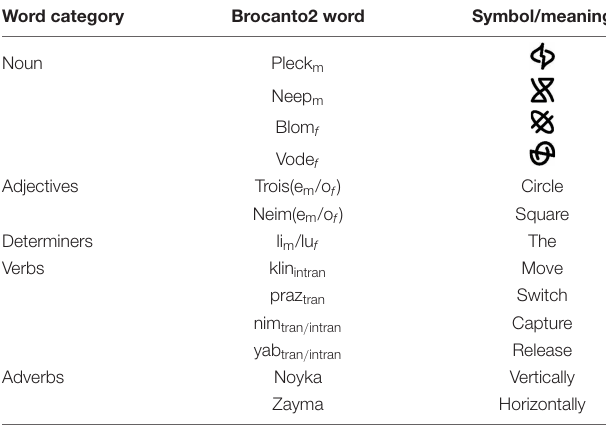
TABLE 1 | Complete list of words used within the artificial language learning